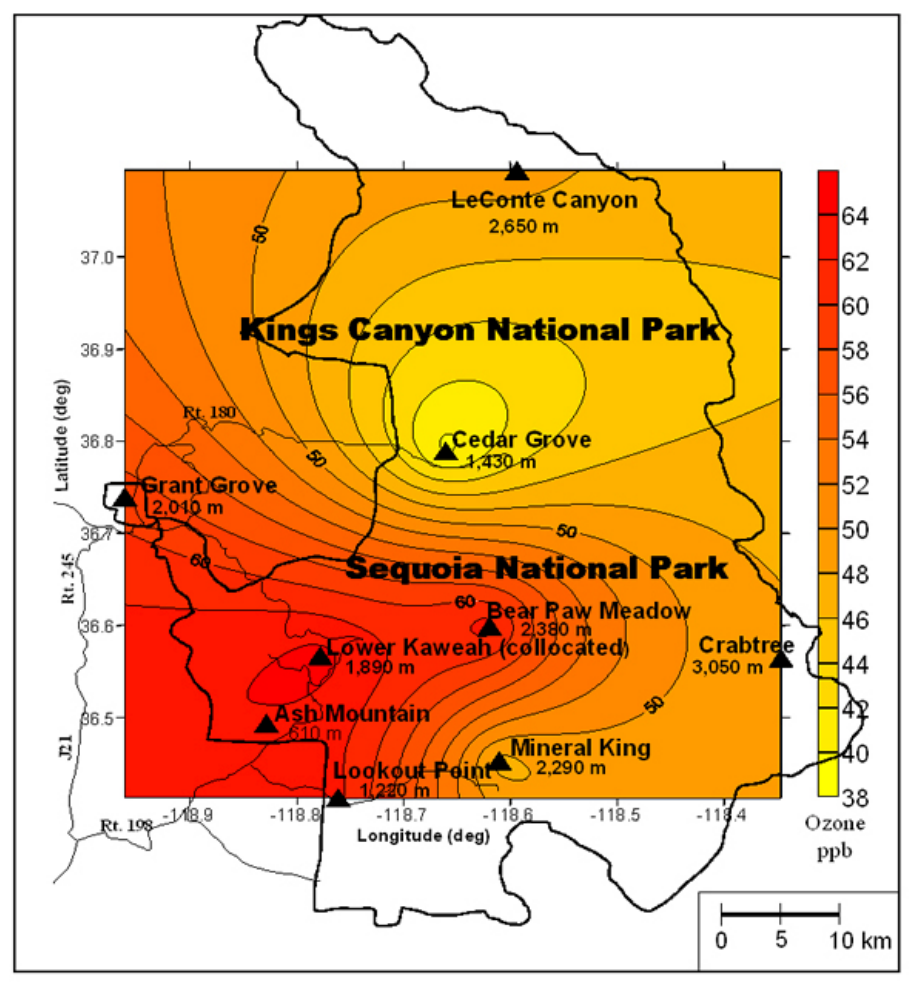
FIGURE 7. Spatial distribution map of kriging interpolated seasonal average ozone for Sequoia–Kings Canyon national parks.